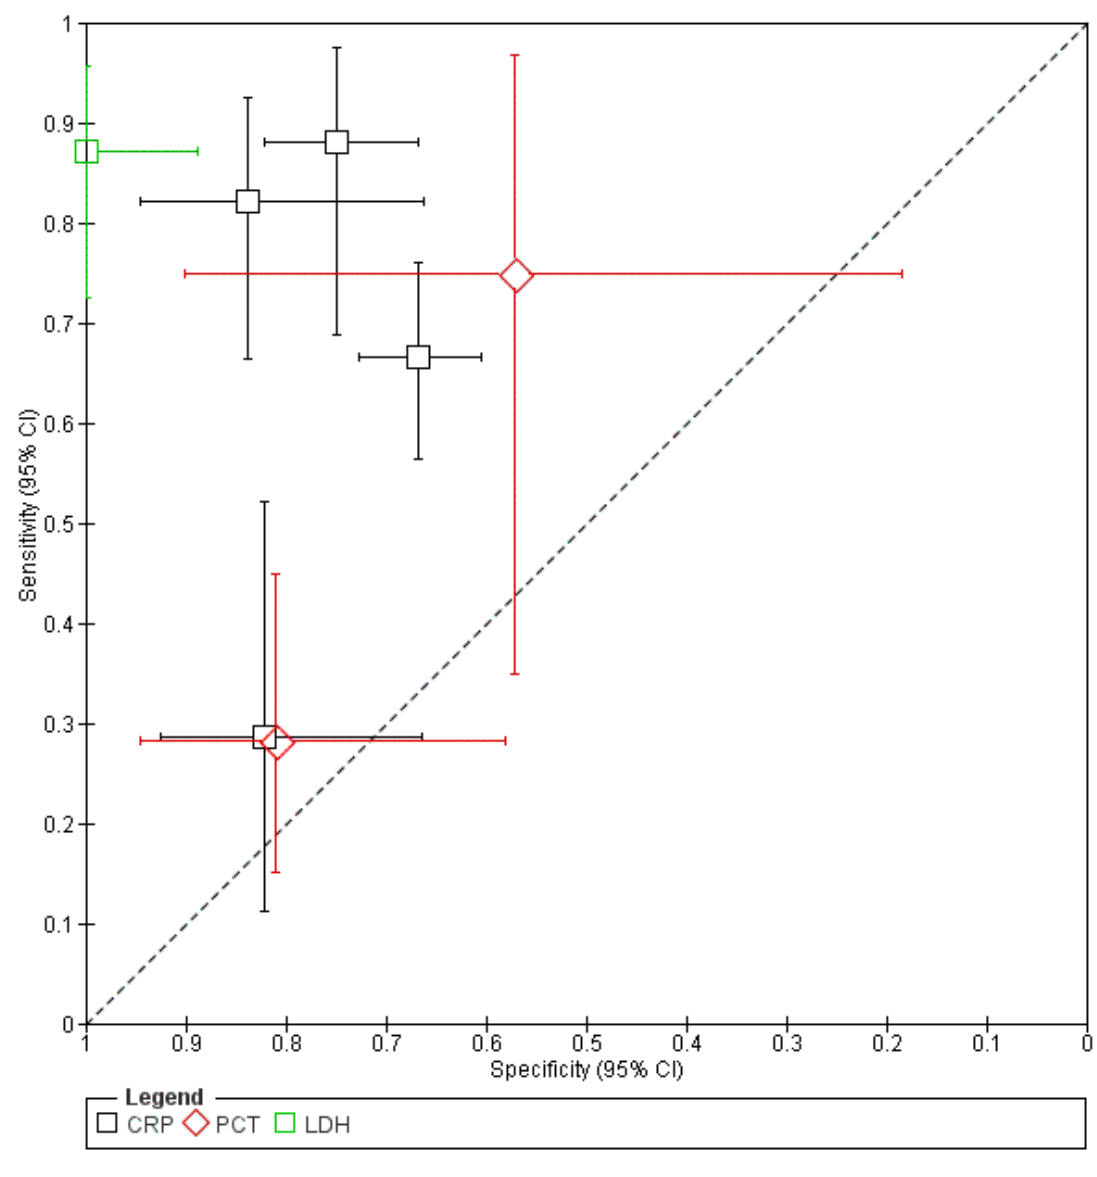
Figure 4. Summary receiver operating characteristic (SROC) plot.